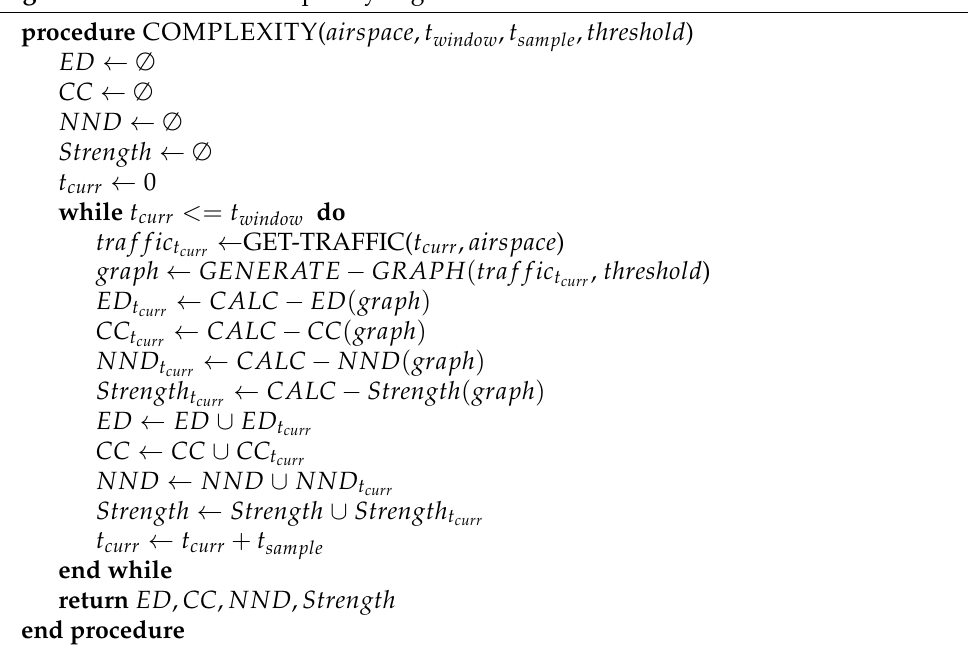
Algorithm 1 Calculate Complexity Algorithm